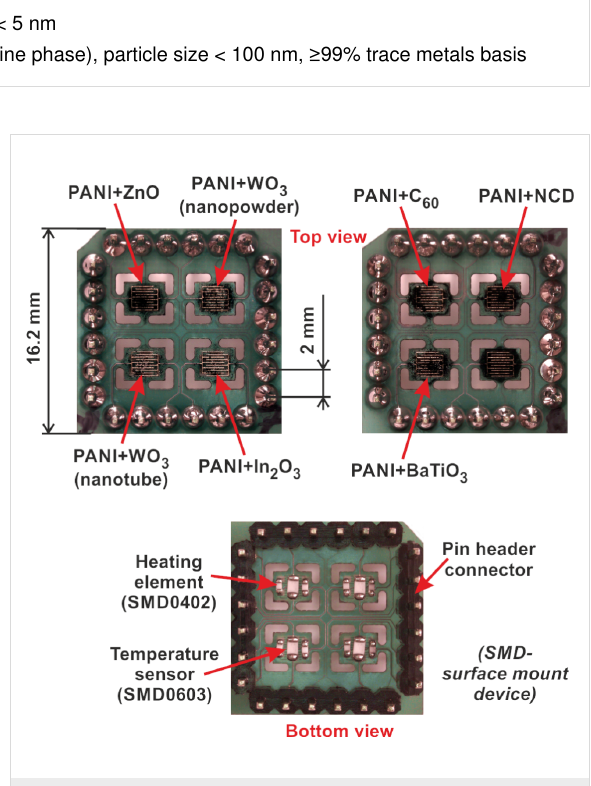
Figure 14: Sensor array with nanocomposite sensing layers with dimensions and bottom view with heating elements and temperature